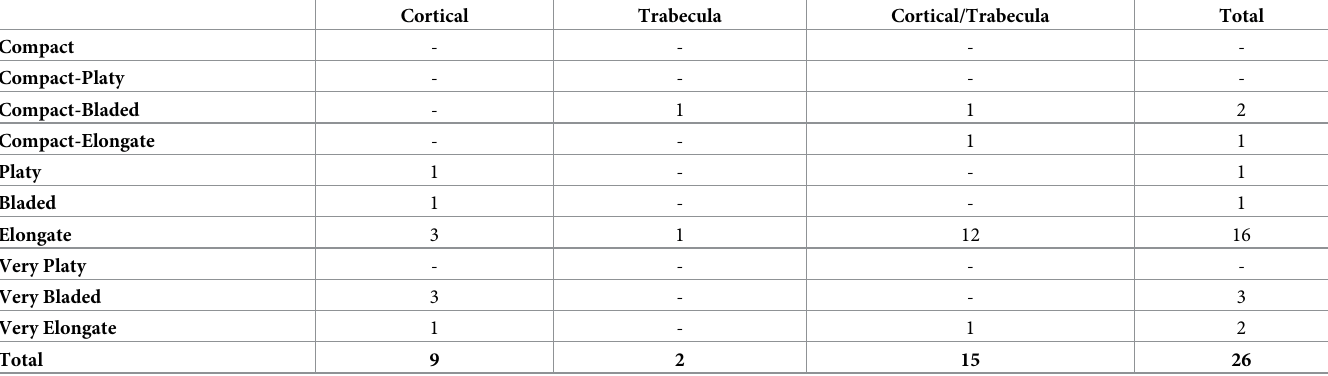
Table 10. Numbers of bone fragments by composition and shape categories following Sneed and Folk [103].